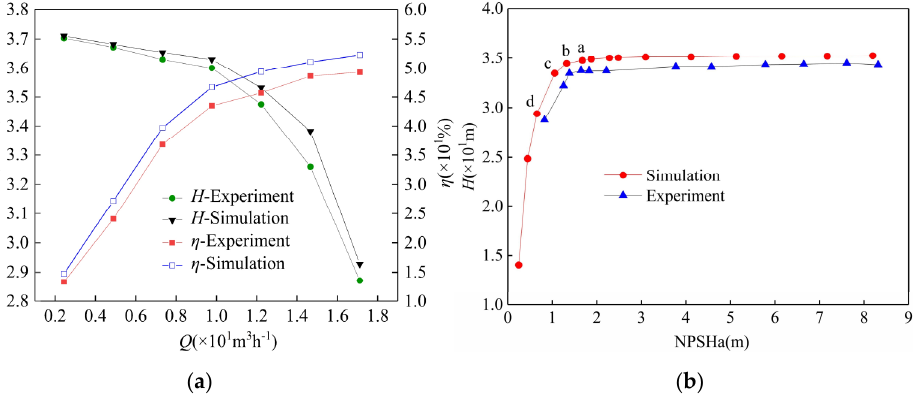
Figure 5. Performance curves of centrifugal pump with an inducer: ( a ) External performance curve; ( b ) Cavitation performance curve at Q d .